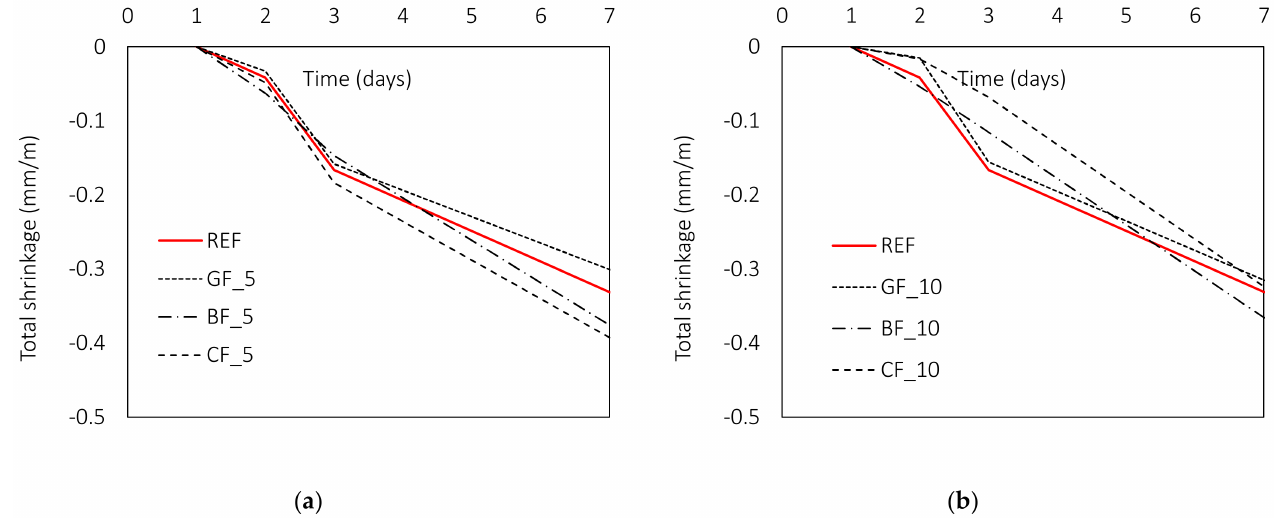
Figure 10. Influence of fibre type and length on early age total shrinkage: ( a ) l f = 5 mm, ( b ) l f = 10 mm.